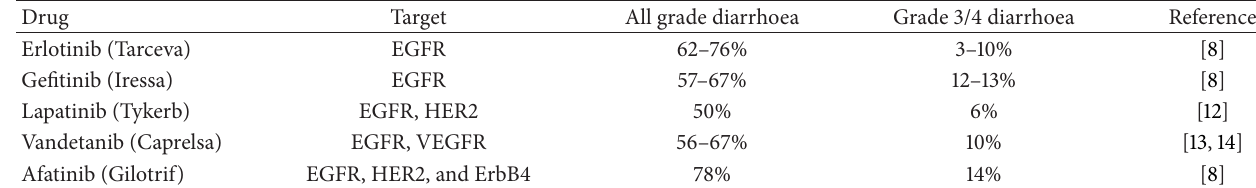
Table 1: Diarrhoea associated with FDA approved TKIs targeting